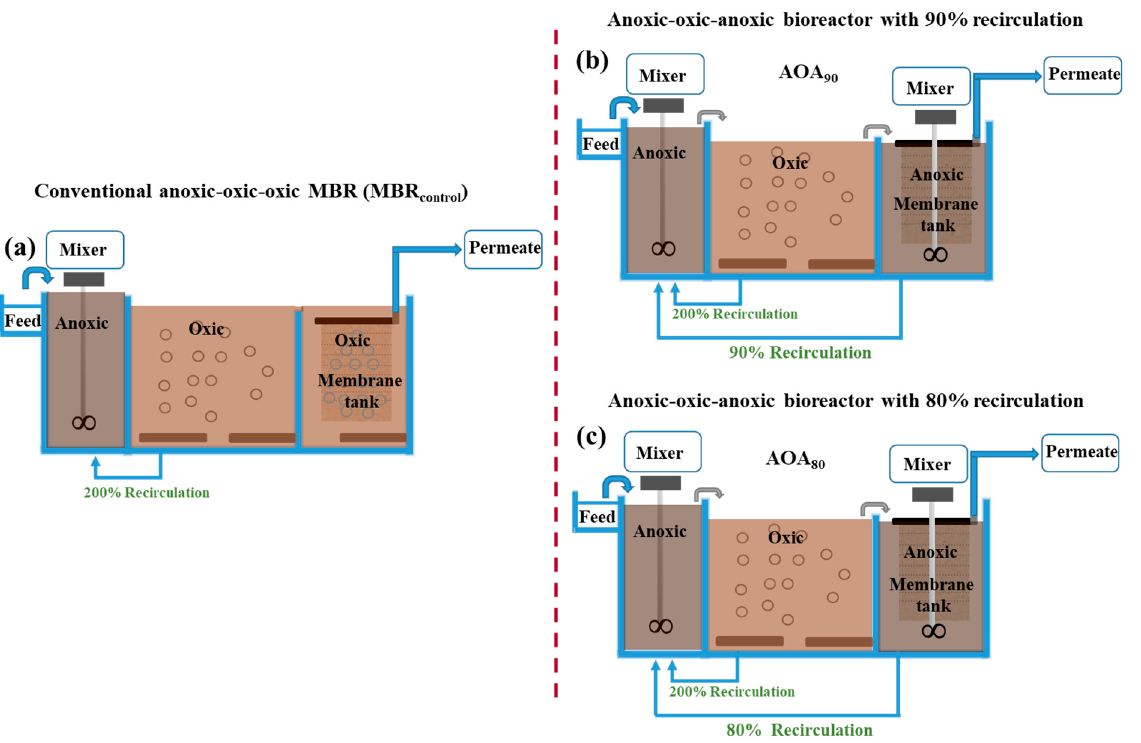
Figure 1. Configuration of conventional anoxic-oxic-oxic MBR (MBR control ) ( a ) and membrane controlled anoxic-oxic-anoxic bioreactors with 90% (AOA 90 ) ( b ) and 80% (AOA 80 ) ( c ) recirculation.